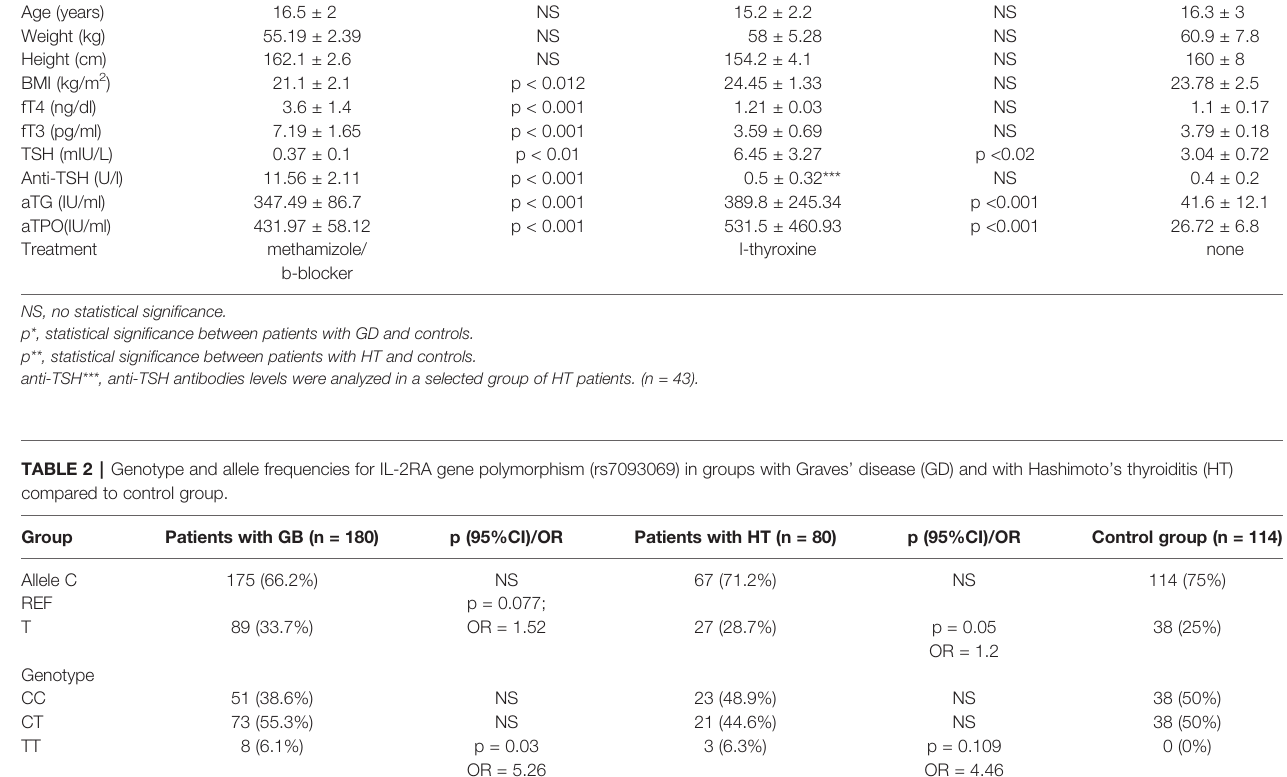
TABLE 1 | Clinical characteristics of patients with Graves ’ disease (GD) and with Hashimoto ’ s thyroiditis (HT) and control group. GD (mean ± SD) p* HT (mean ± SD)